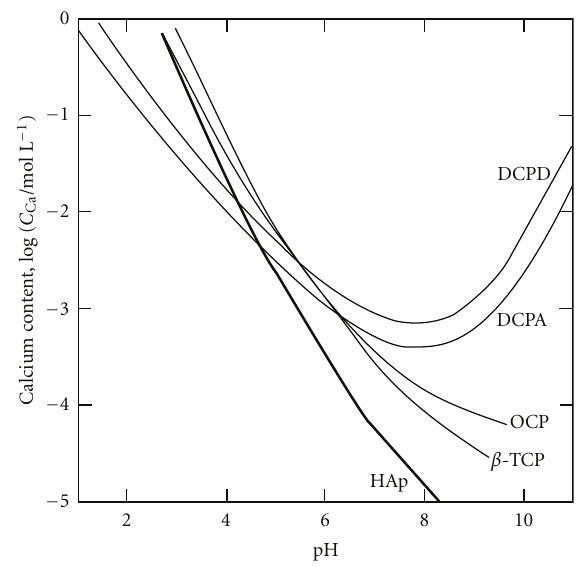
Figure 2: Solubility curves of calcium orthophosphoric com- pounds at 37 ◦ C, depending on pH in aqueous solution. HAp: hydroxyapatite (Ca 10 (PO 4 ) 6 (OH) 2 ), TCP: calcium phosphate (Ca 3 (PO 4 ) 2 ), OCP: octacalcium phosphate (Ca 8 H 2 (PO 4 ) 6 5H 2 O), DCPA: dicalcium phosphate anhydrous (CaHPO 4 ), DCPD: dical- cium phosphate dihydrate (CaHPO 4 2H 2